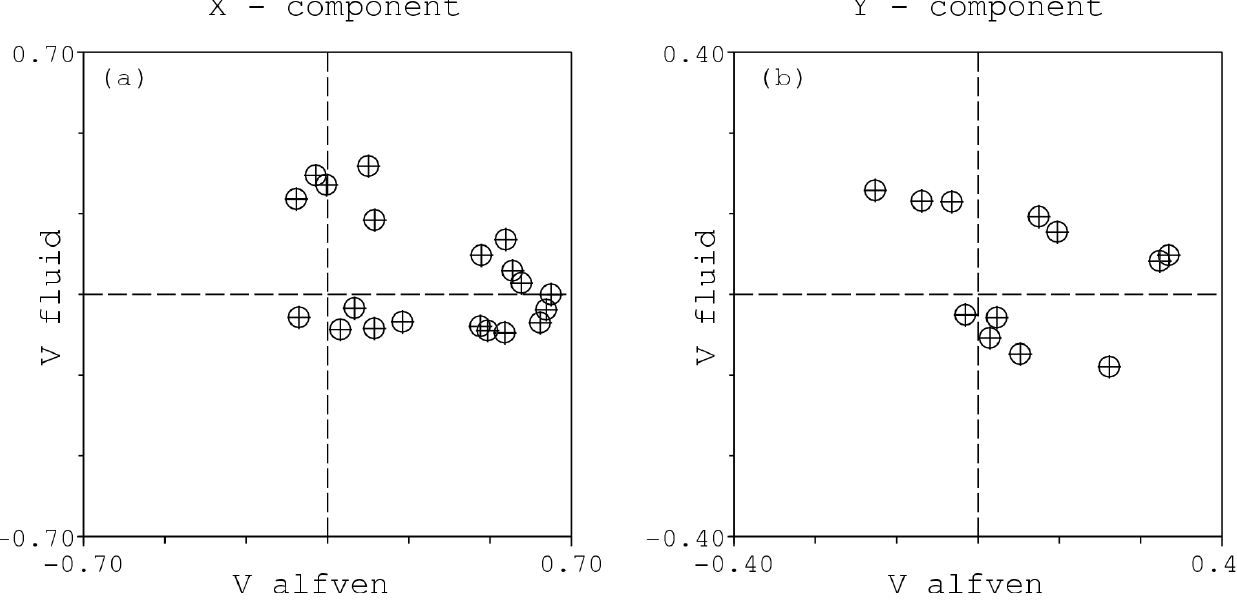
sides of the MP) that gives 20 couples of Alfv´en and fluid